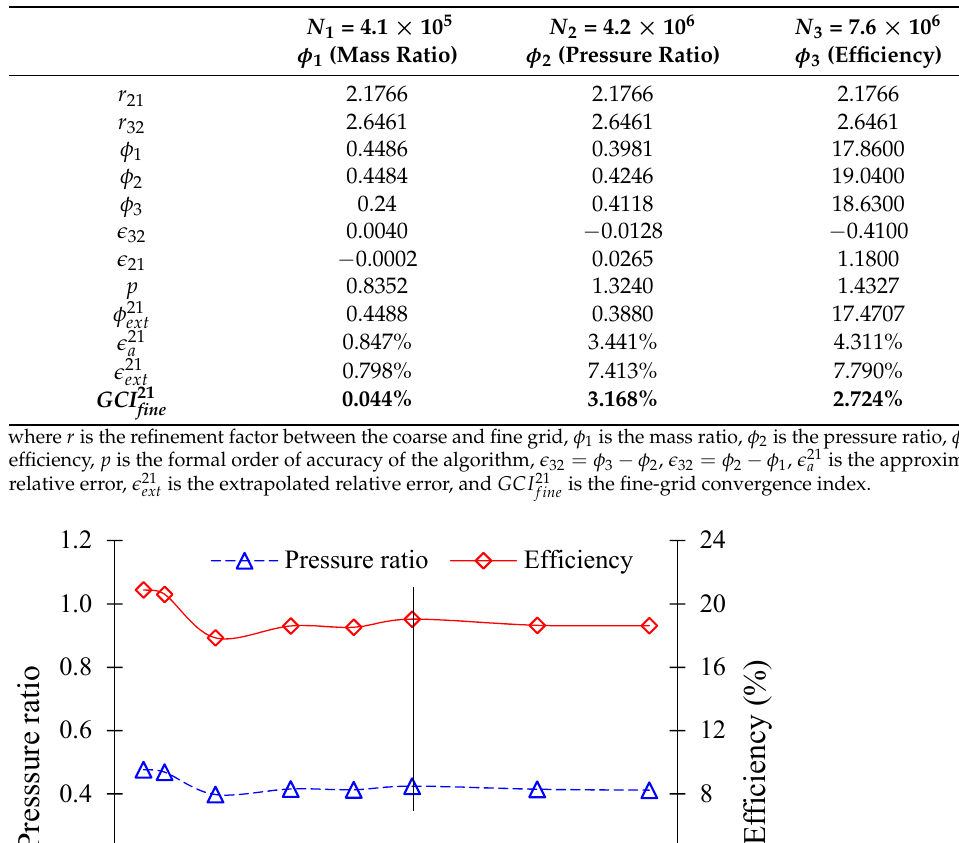
Table 4. Grid dependency test for AJP CFD analysis via GCI method.